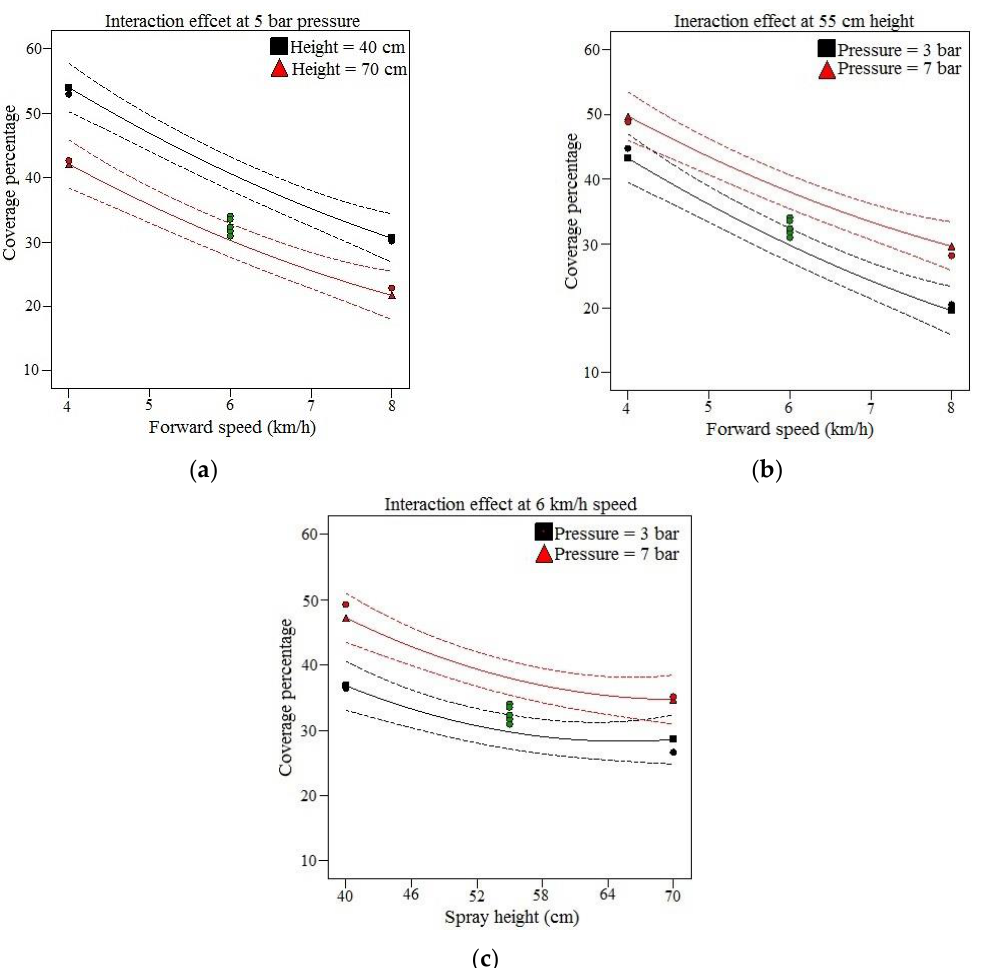
Figure 8. Coverage percentage: ( a ) relationship between forward speed and spray height at 5 bar pressure; ( b ) relationship between forward speed and pressure at 55 cm spray height; ( c ) relationship between spray height and pressure at 6 km/h speed.